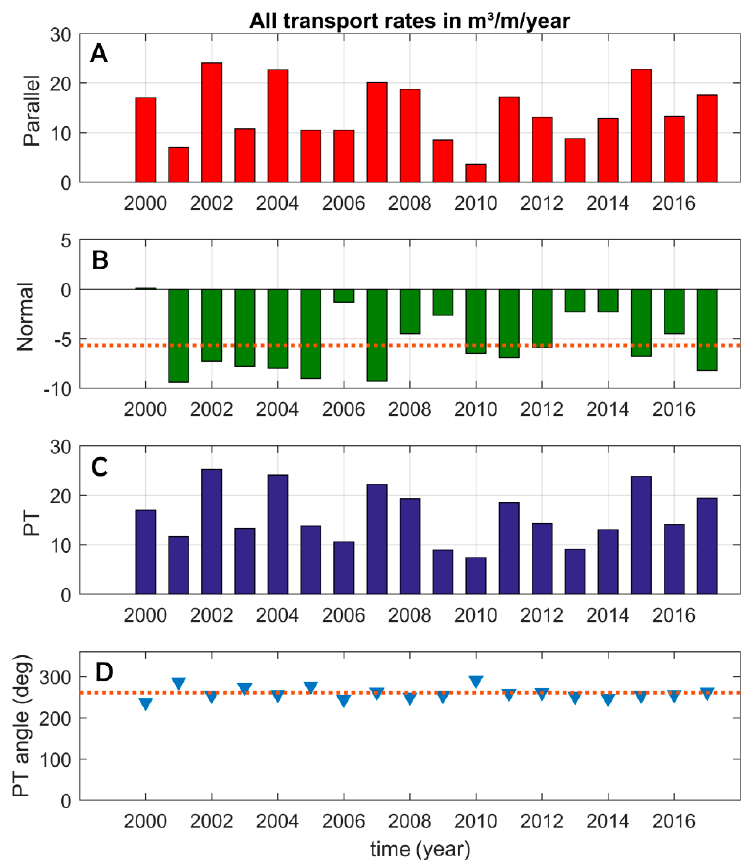
Figure 24. Decadal evolution of potential dune growth at section 50 of the Belgian coast.